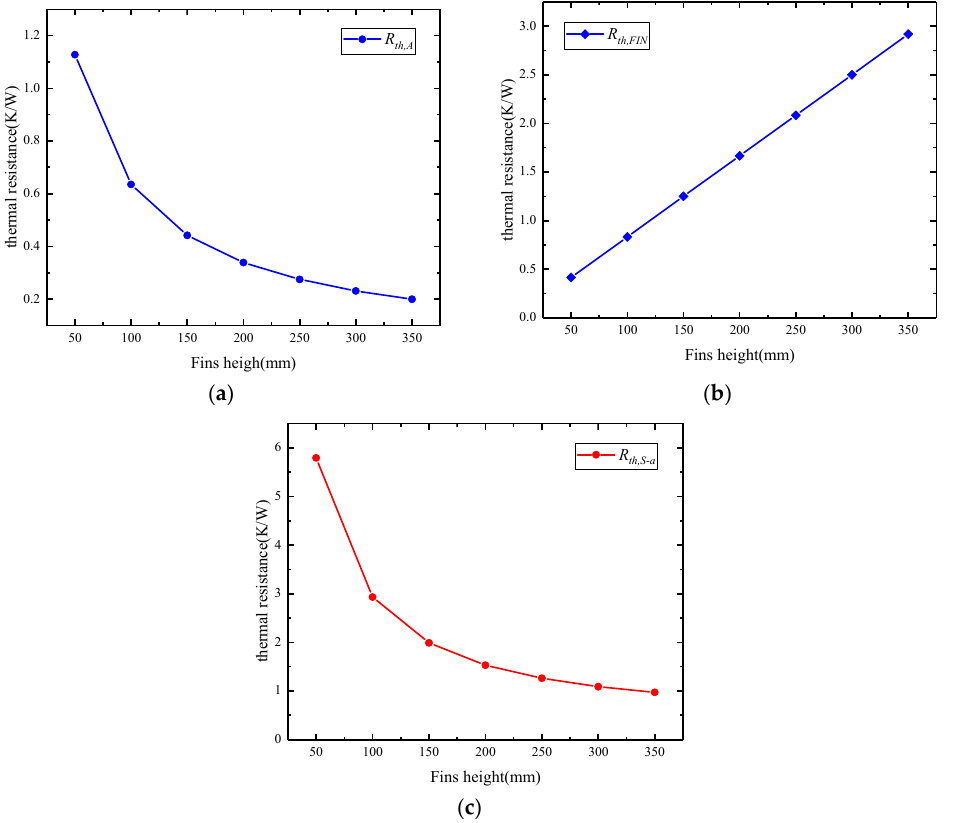
Figure 11. The changes in thermal resistance with different height of fins. ( a ) Comparison of the R th,A with different height of fins; ( b ) Comparison of the R th,FIN with different height of fins; ( c ) Comparison of the R th,S − a with different height of fins.